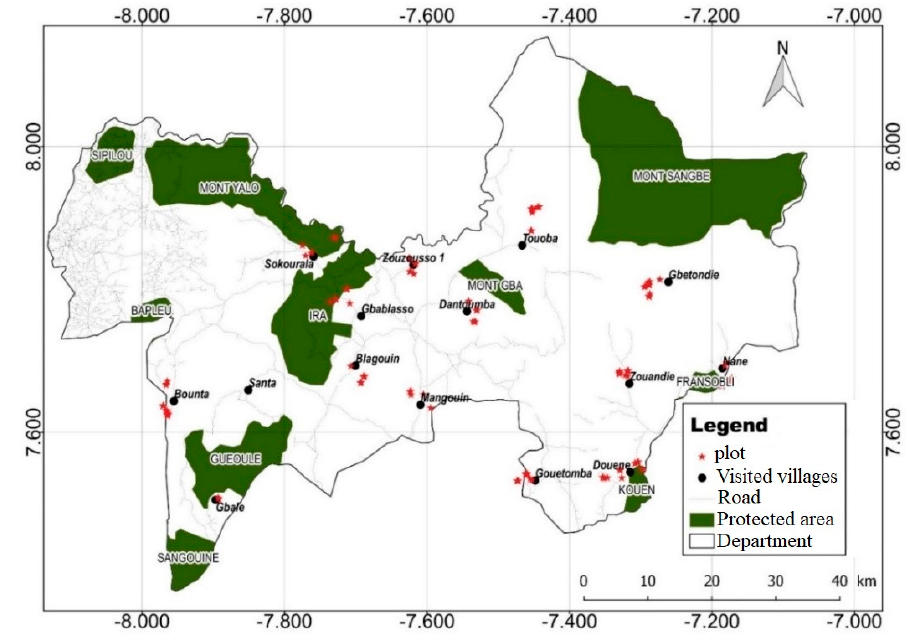
Figure 2. Villages surveyed in Biankouma region .